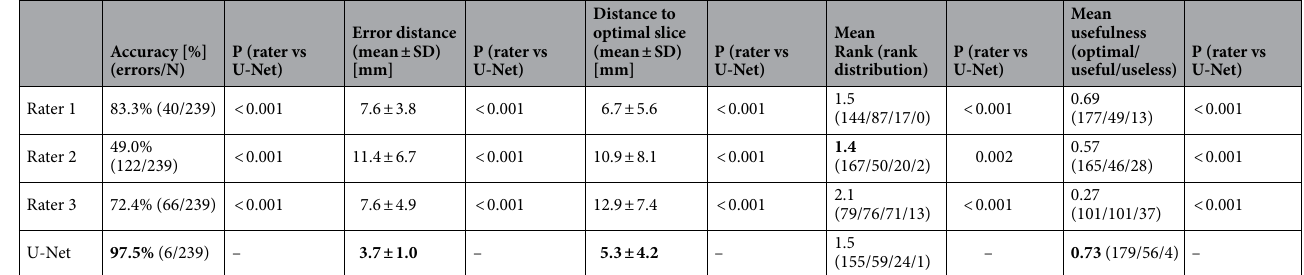
Table 2. Accuracy of the radiographers. The mean rank and usefulness were judged by a board-certified radiologist. All P-values are measured between the corresponding rater and the U-Net. The mean usefulness indicates a mean score, where a score of 1.0 would be attained if all scan ranges were judged to be optimal, and − 1.0 if all scan ranges were useless. As all tests are for non-inferiority, a significant P-value indicates non- inferiority. Best values were marked in bold.